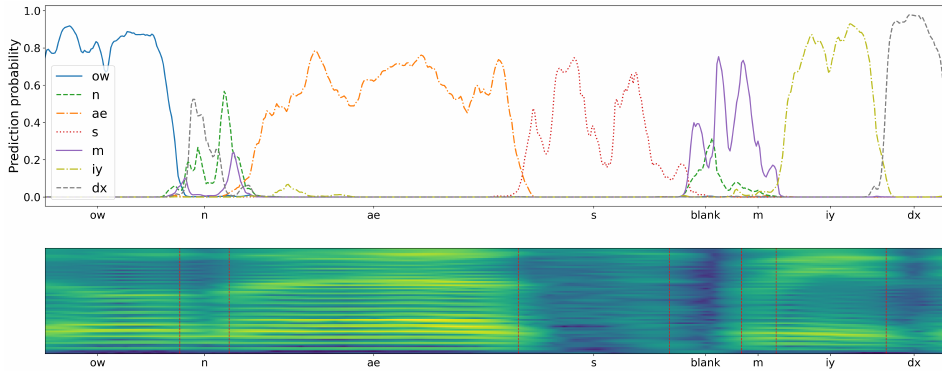
Figure 9. Probabilities produced for the same spectrogram as in Figure 8 by a classifier trained using the sliding-window scheme. Observe an erroneous detection of a consonant ‘dx’ in the leading part of the plot.